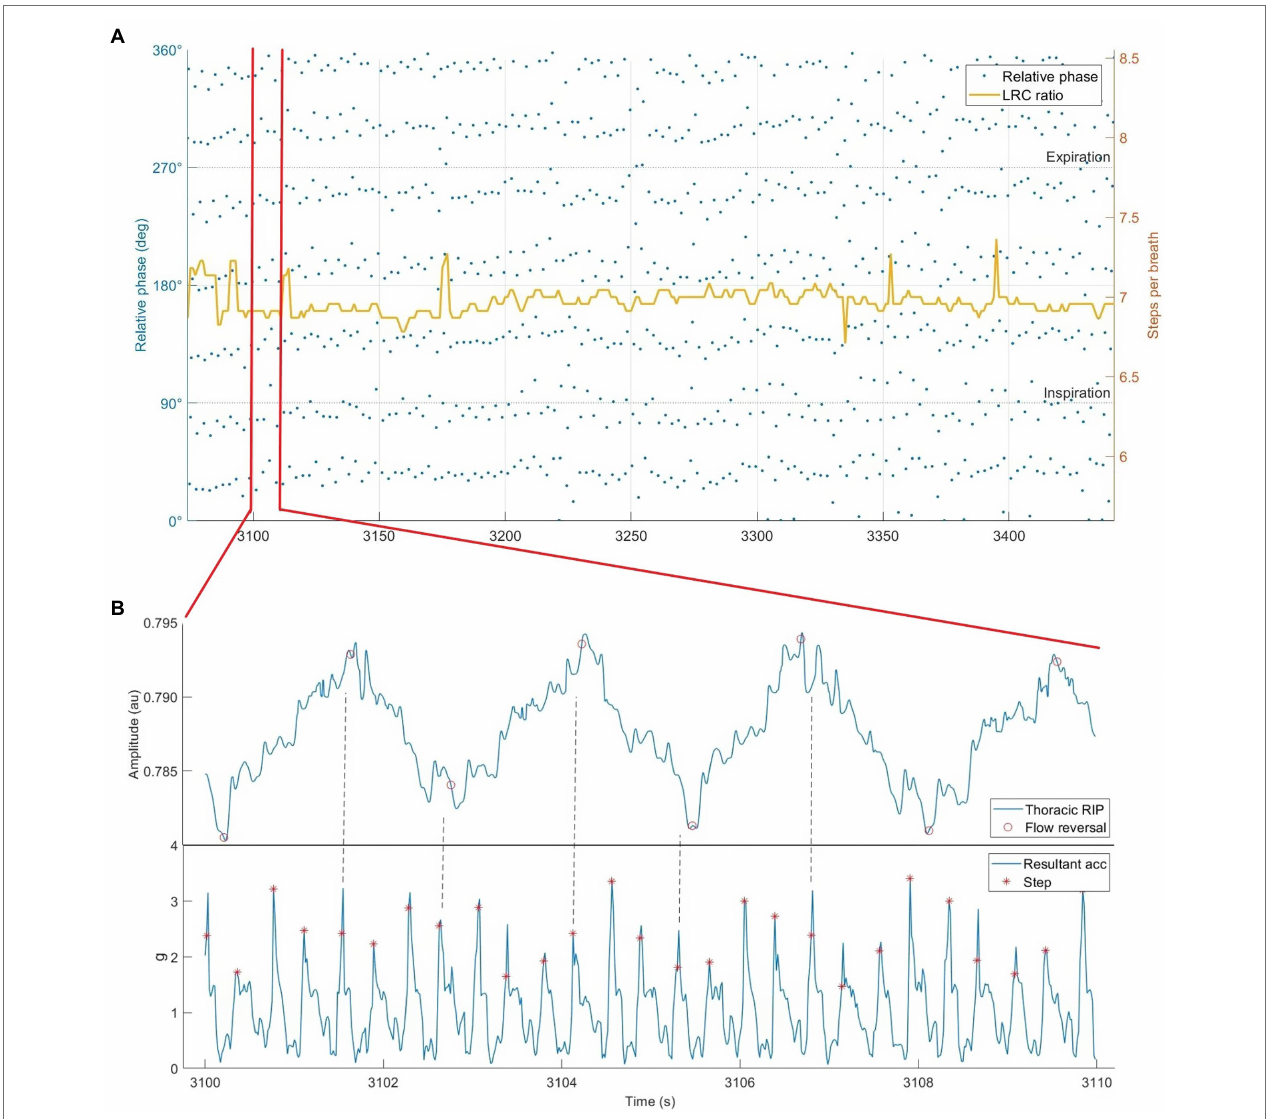
FIGURE 7 | Respiratory inductance plethysmography data from our lab showing locomotor-respiratory coupling (LRC). (A) Phase synchrogram and LRC ratio plotted during 8 min of running at an instructed LRC ratio 3:4 (steps per inhale:steps per exhale). Note the quantity of steps synchronized with inspiration vs. expiration. All relative phase shifted 90 ° for visibility. (B) Subsection of 10 s of raw RIP and hip-mounted accelerometer data while running at 3:4 LRC. Dotted lines added to emphasize step & flow reversal